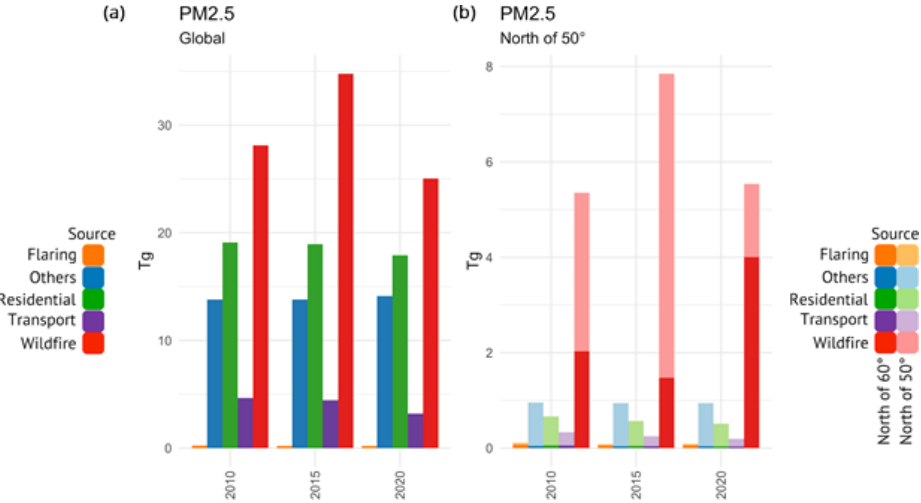
Figure 5. Annual PM 2 . 5 emissions for 2010, 2015, and 2020 from four anthropogenic source sectors (residential, transport, flaring, others) from GAINS and wildfires from GFAS, presented globally (a) and (b) at 50 to 60 ◦ N (lighter colours of the cumulative bar) and north of 60 ◦ N latitude (darker colours of the cumulative